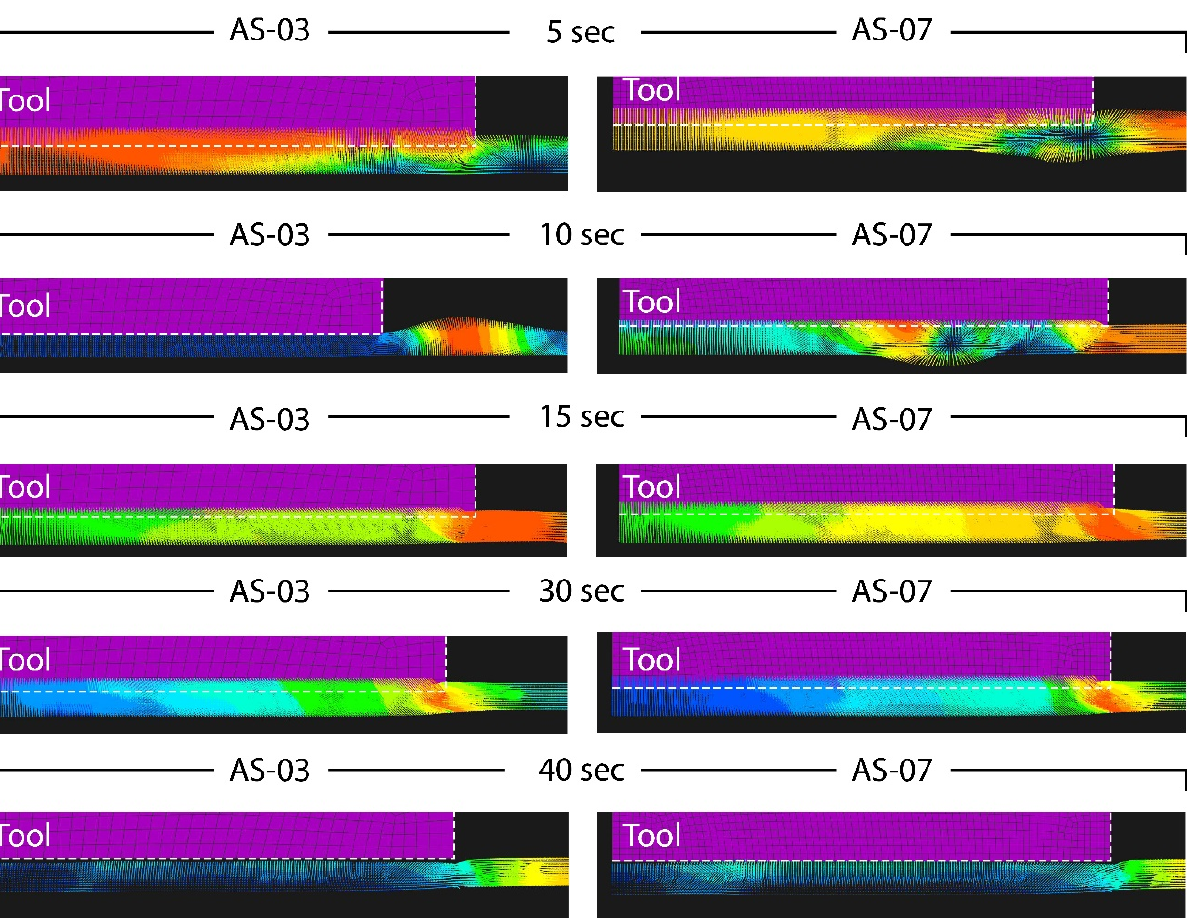
Figure 6. Material flow in samples AS-03 and AS-07 at the different time stages ( a – e ).